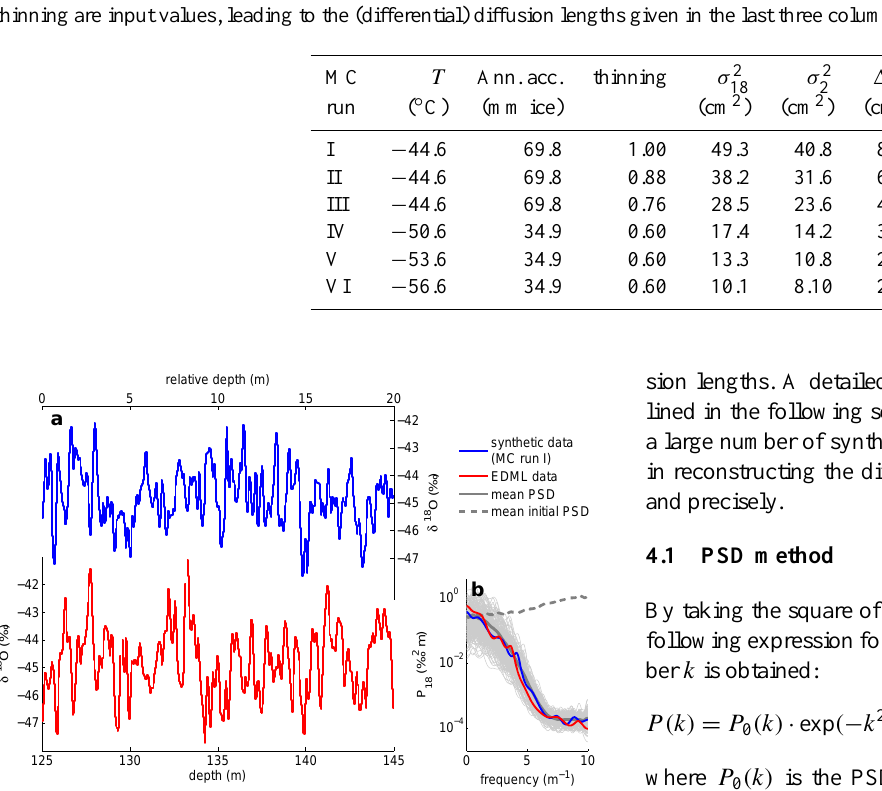
Figure 1. δ 18 O records of a synthetic data set (blue) and of the EDML ice core (red). For both records the sample size is 5cm. (b) shows the power spectral densities of each isotope record together with those of 200 other synthetic data sets of MC run I. The average PSD of the 200 runs is shown as the dark grey solid line. The dashed line is the average PSD of the initial signals (before diffusion) of these